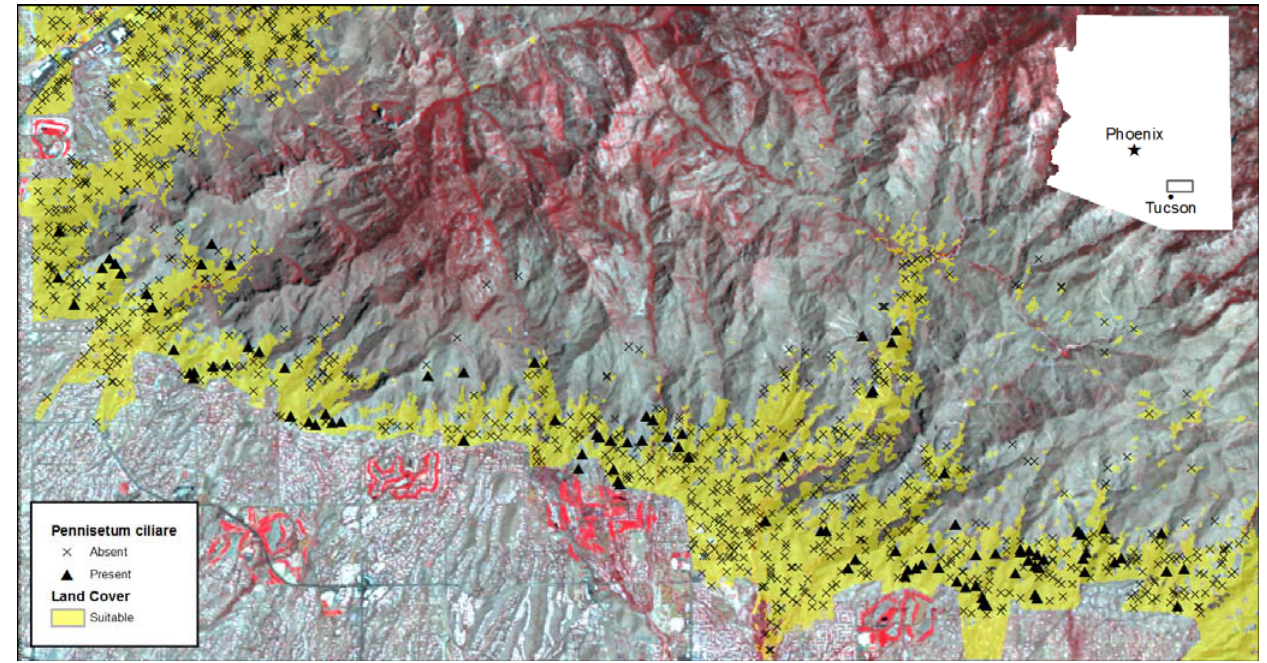
Figure 3. Map of study area showing validation points overlaid on Landsat TM Image from 26 May 2007 (path 36, row 38). The yellow overlay shows Southwest Regional GAP Analysis cover classes in which P. ciliare is